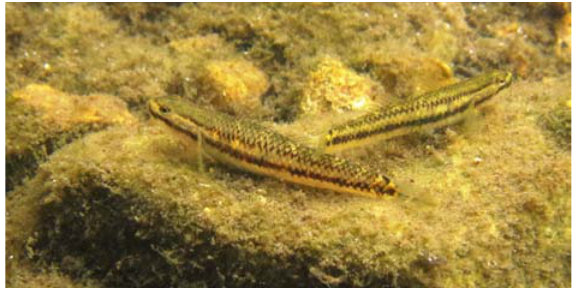
Image 5. Stiphodon atropurpureus (female). Image 6. Stiphodon imperiorientis (male) during courtship display.